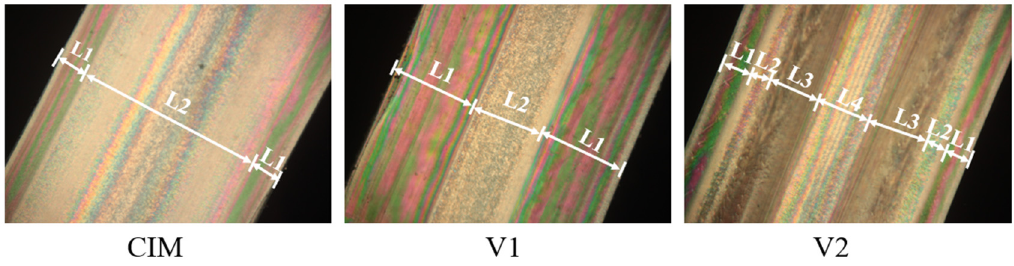
Figure 2. Polarized optical microscopy (POM) photographs of different specimens. L1 and L3 represent the shear layer, L2 and L4 are the spherulites layer.